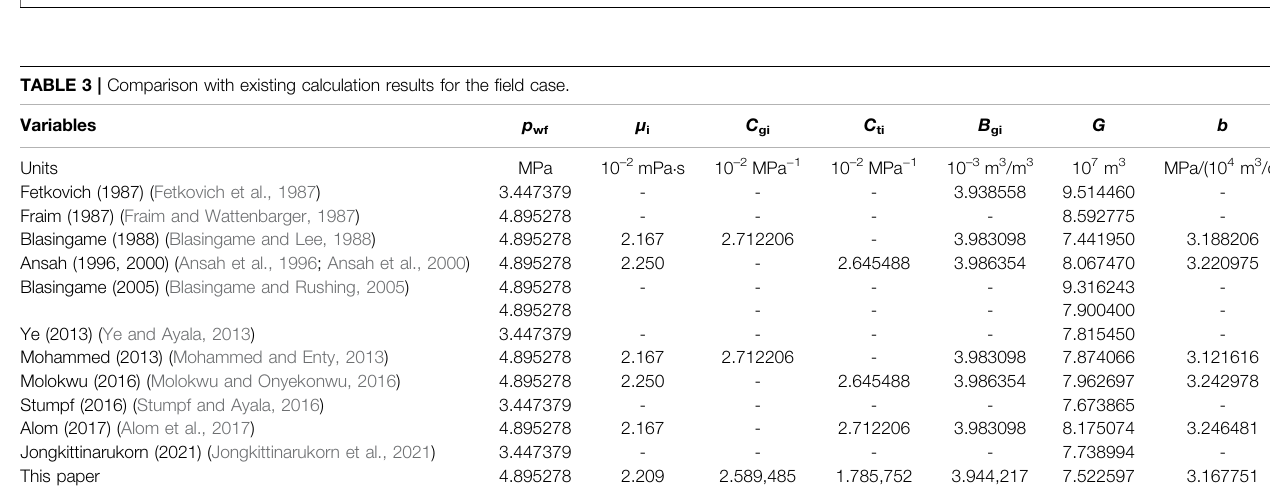
FIGURE 12 | E ( Y ) vs. t for the fi eld case ( p wf (cid:1) 4.895278 MPa).